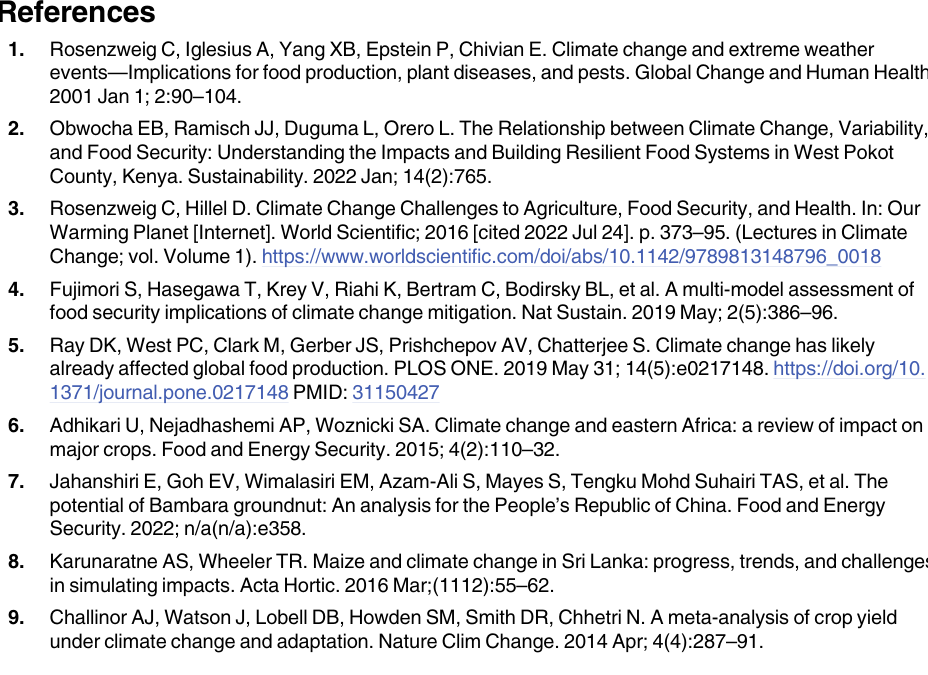
S1 Table. Description of general circulation models (GCMs) used in the